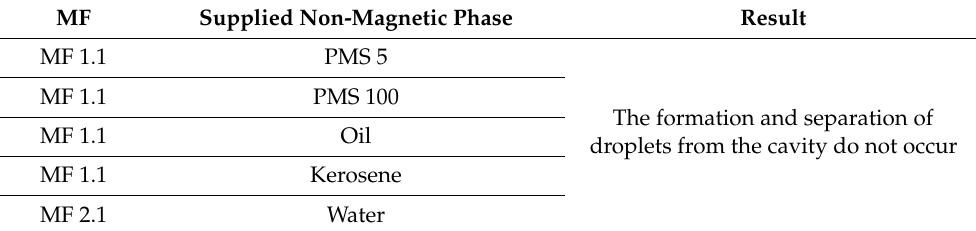
Table 3. Results of Experiment No.